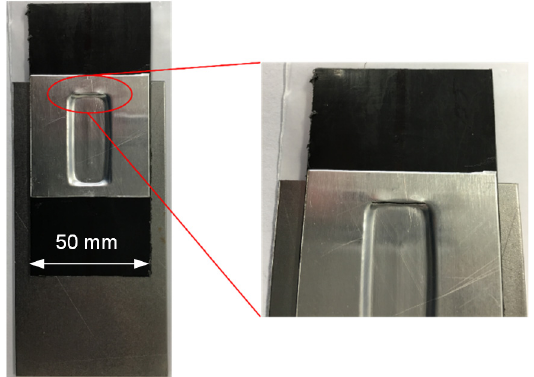
Figure 17. Tearing in the thin 5754 aluminum patch at the upper edge at high discharge energies.